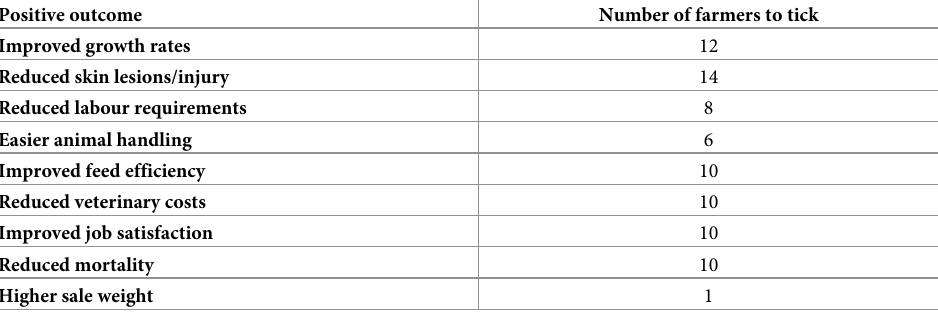
Fourteen farmers responded to this question.